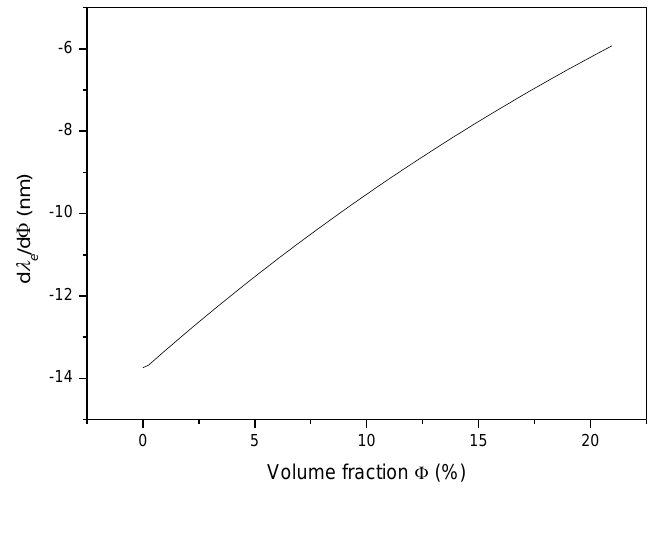
Figure 6. Calculated sensitivity of equalization wavelength  the investigated binary liquid